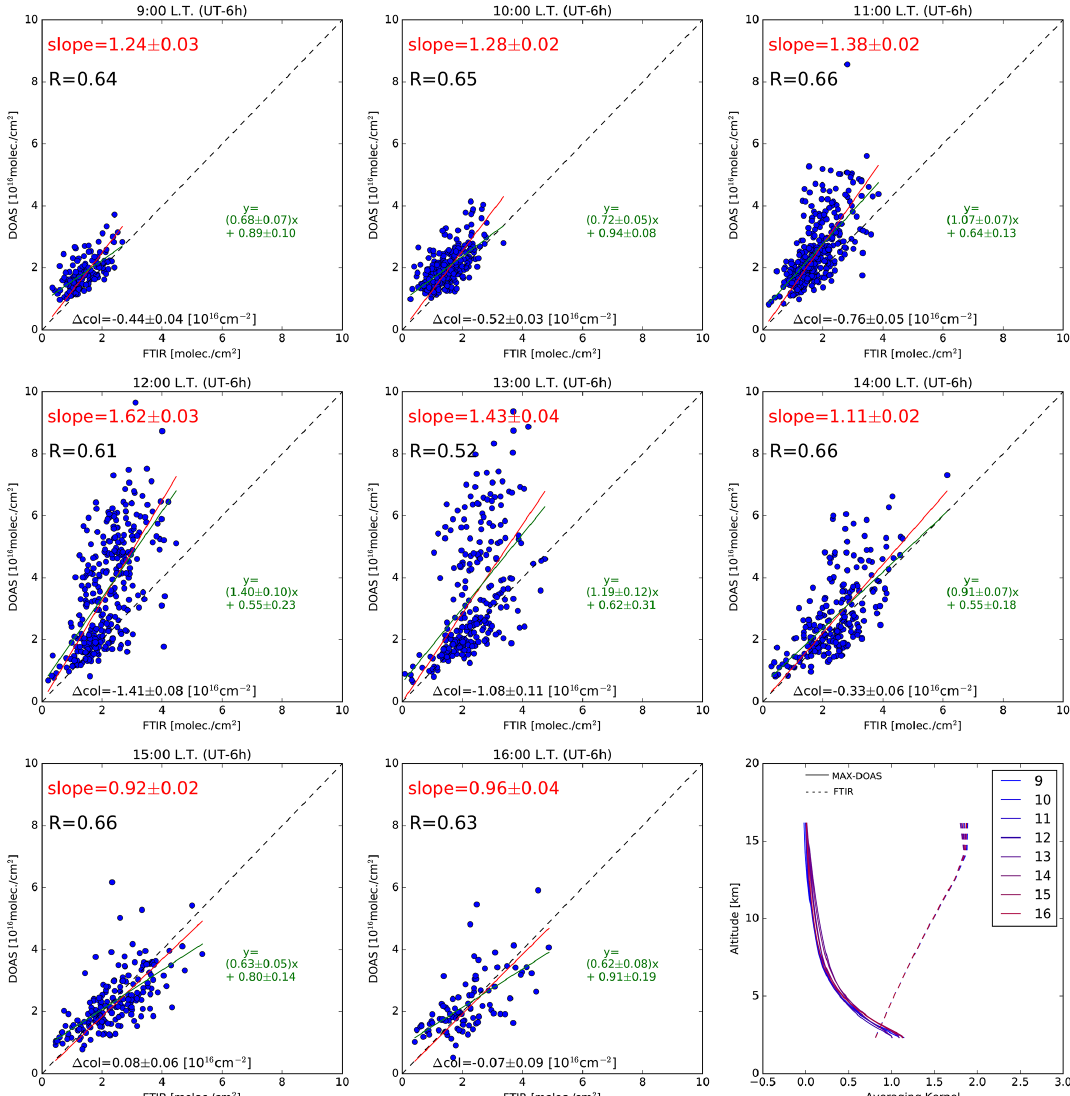
Figure 10. Hourly FTIR versus MAX-DOAS comparisons at UNAM between 09:00 and 16:00LT.